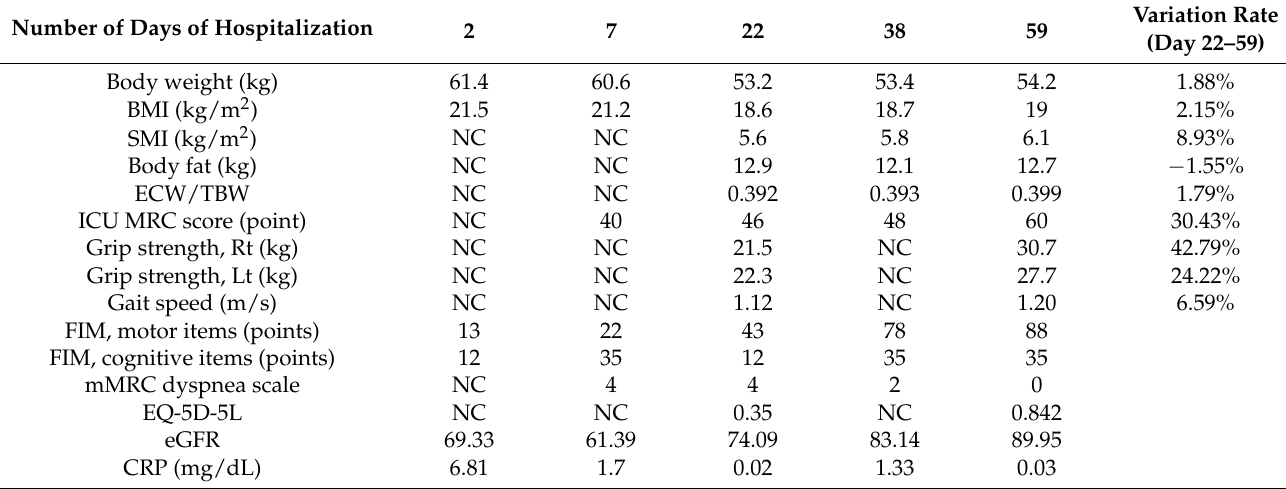
Table 1. Timeline of the patient’s physical and nutritional